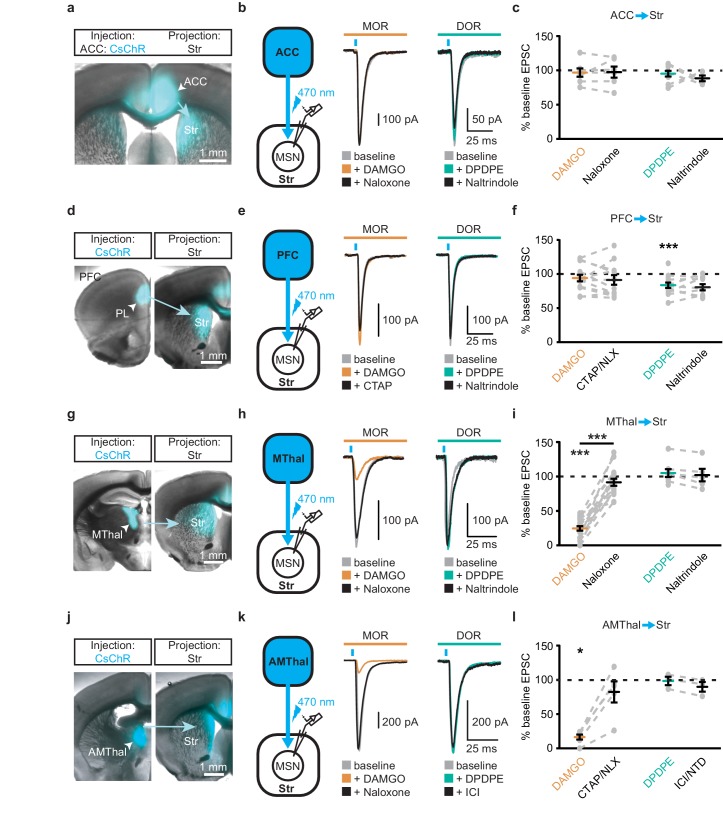
Single channelrhodopsin injections reproduced specific effect of mu-opioid-mediated inhibition of thalamic but not cortical inputs.Virus expressing CsChR was injected into the ACC (a–c), the PFC (d–f), the MThal (g–i), or the anteromedial thalamus (AMThal) (j–l) as four sets of the experiments. (a, d, g, j) Representative images of the injection and projection for the above four sets of experiments, respectively. (b, e, h, k) Viral infection and optical stimulation schematic and example recordings of four sets of experiments, respectively. oEPSCs were evoked under baseline conditions (gray) and in the presence of DAMGO (1 µM, orange) followed by CTAP or naloxone (NLX) (1 µM, black), or DPDPE (1 µM, teal) followed by naltrindole (NTD) or ICI 174,864 (ICI) (0.3 µM, black). (c, f, i, l) Summary data of effects of DAMGO, CTAP/NLX, DPDPE, and ICI/NTD on oEPSC amplitude for the above four sets of experiments, respectively. (c) DAMGO/naloxone: N = 4/4, n = 7/6, SM = 0.054, p=0.974; DPDPE/naltrindole: N = 5/4, n = 9/5, SM = 4.539, p=0.103. (f) DAMGO/naloxone: N = 9/8, n = 14/12, SM = 2.286, p=0.319. DPDPE/naltrindole: N = 9/6, n = 14/10, SM = 8.227, p<0.05, IDPDPE: 83.4 ± 3.9% of baseline, W(13) = 4, p<0.01. (i) DAMGO/naloxone: N = 15/13, n = 19/16, SM = 25.660, p<0.001, IDAMGO: 24.5 ± 3.3% of baseline, W(19) = 0, p<0.001, DAMGO vs. naloxone, W(12) = 0, p<0.001; DPDPE/naltrindole: N = 7/5, n = 8/5, SM = 2.522, p=0.283. (l) DAMGO/naloxone: N = 5/4, n = 6/5, SM = 9.399, p<0.01, IDAMGO: 16.5 ± 3.7% of baseline, W(6) = 0, p<0.05; DPDPE/naltrindole: N = 2/2, n = 3/3, SM = 4.667, p=0.097. Blue bars: 1 ms of 470 nm light stimulation. Skillings-Mack test followed by paired Wilcoxon signed-ranks test post-hoc analysis. *p≤0.05; **p≤0.01; ***p≤0.001. Mean ± standard error of the mean. SM: Skillings-Mack statistic.